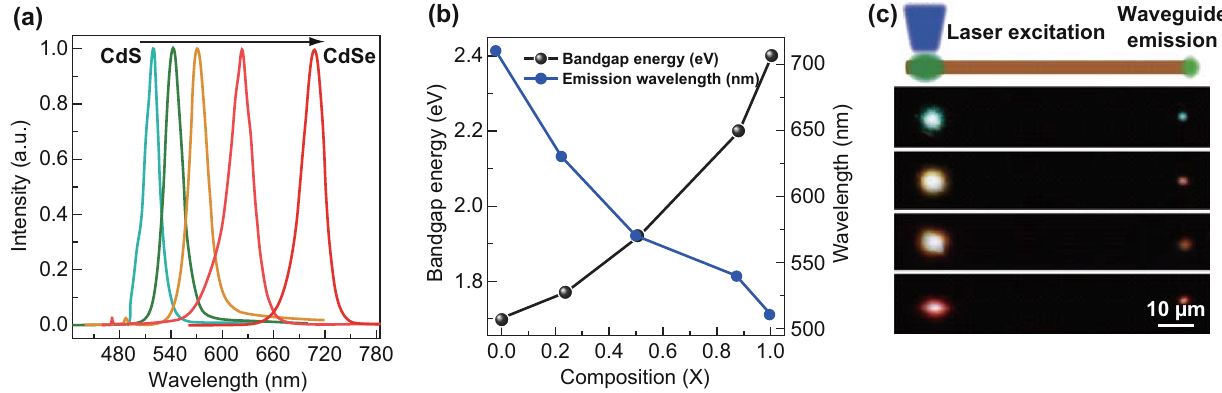
Fig. 3 Optical properties of the in-plane-directional CdS x Se 1 - x NWs. a Tunable PL spectra of the as-grown CdS x Se 1 - x NWs with the emission wavelength shifts from 510 nm (pure CdS) to 710 nm (pure CdSe). b Composition-dependent bandgap energy and the corresponding emission wavelength of the as-grown CdS x Se 1 - x NWs. c The schematic diagram of the CdS x Se 1 - x NW waveguide and the corresponding real-color images of single CdS, CdS 0.8 Se 0.2 , CdS 0.24 Se 0.76 , and CdSe NWs,